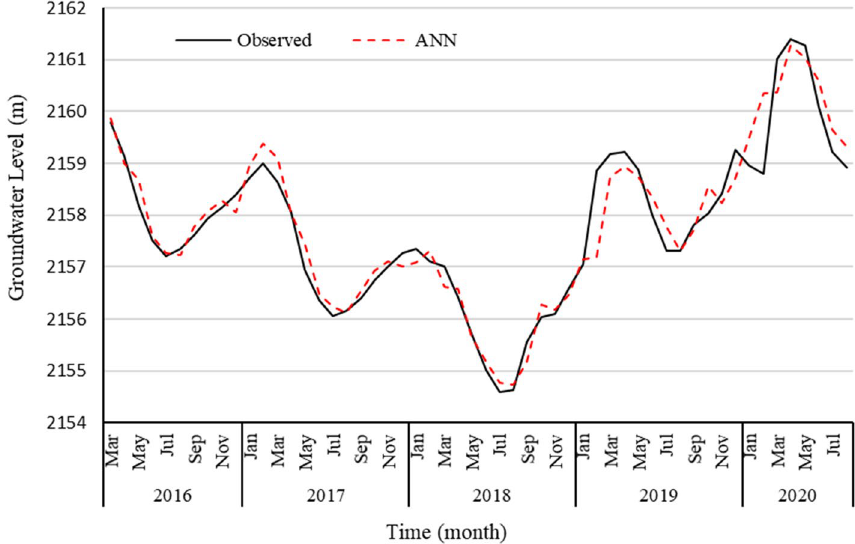
Fig. 7 Comparison of the ANN model with observed data